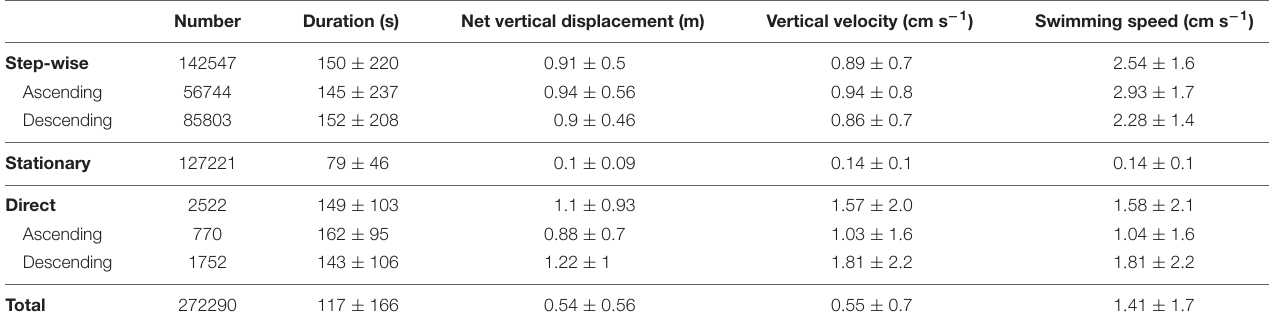
TABLE 2 | Major track parameters obtained by automatic target tracking for the whole study period from December 1, 2010 to March 31, 2011 (92 days with tracking data).